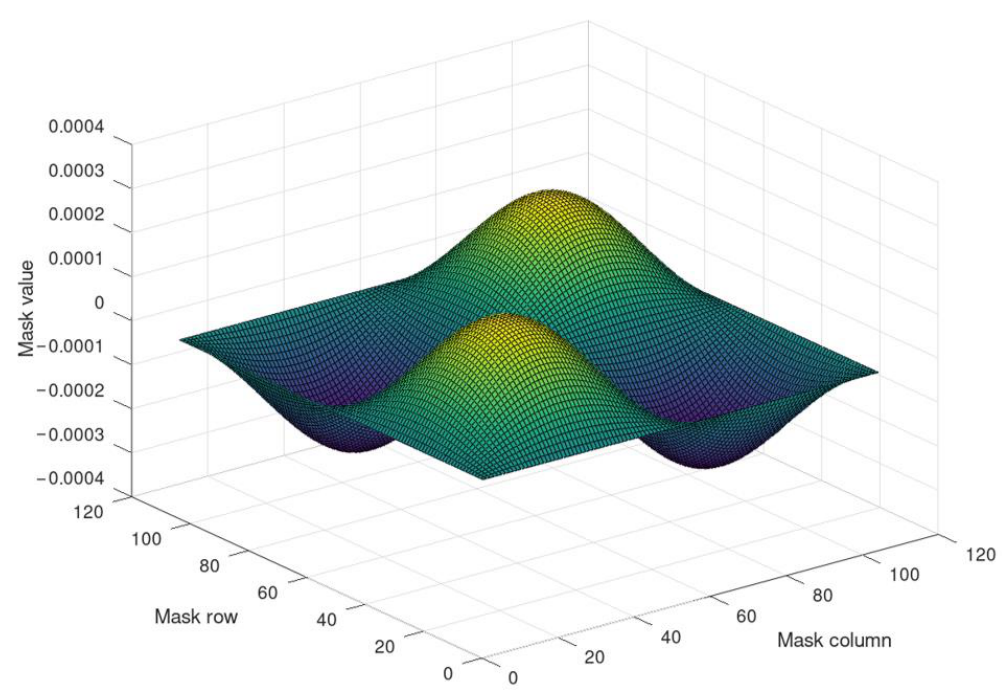
Figure 4. Filter mask designed to emphasize checkerboard corners in an image.